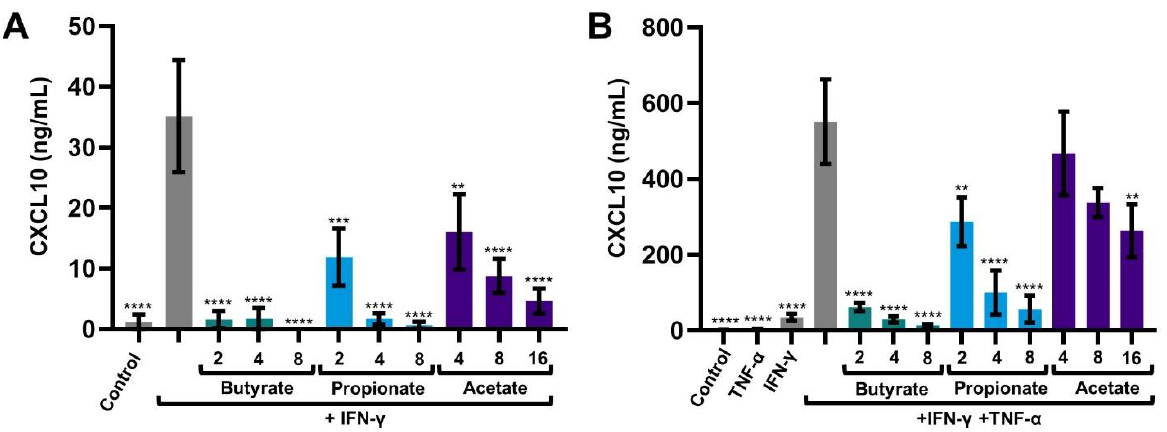
Figure 1. CXCL10 release by intestinal epithelial cells after 24 h, activated with IFN- γ ( A ) or IFN- γ +TNF- α ( B ) and treated with 2, 4, 8 and 16 mM butyrate, propionate or acetate. Data are represented as mean ± SEM ( n = 3). Significant differences are shown as ** p < 0.01, *** p < 0.001, **** p < 0.001 compared to IFN- γ ( A ) or IFN- γ+TNF - α ( B ) activated cells.